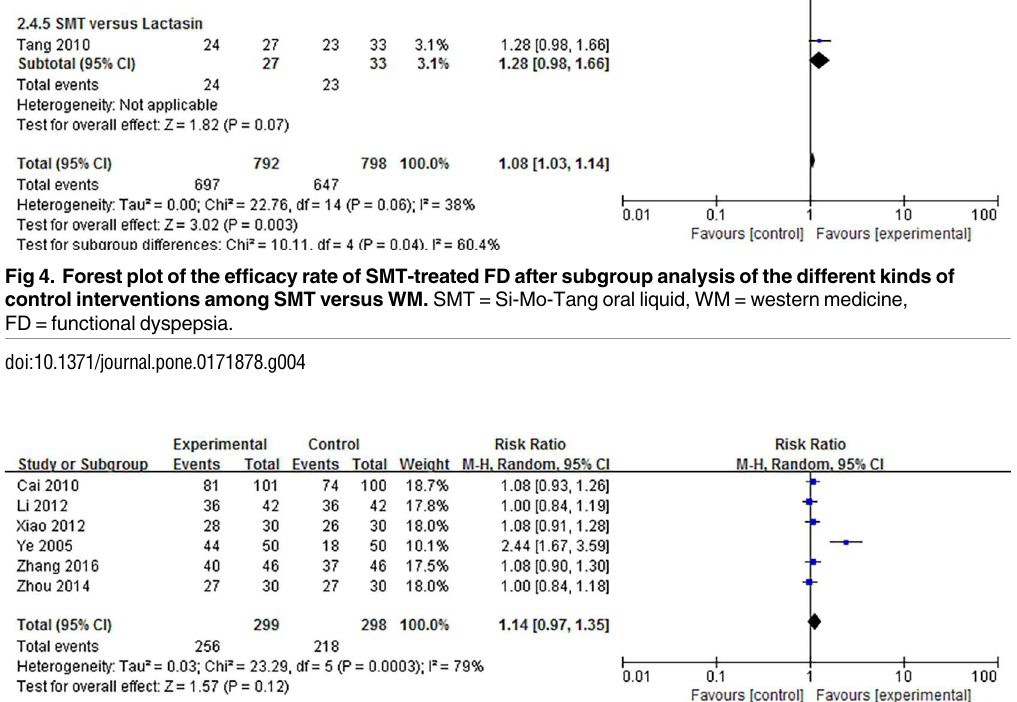
Fig 5. Forest plot of the efficacyrate of SMT-treated FD after excluding poor quality studies. SMT = Si-Mo- Tang oral liquid, WM = western medicine,FD =